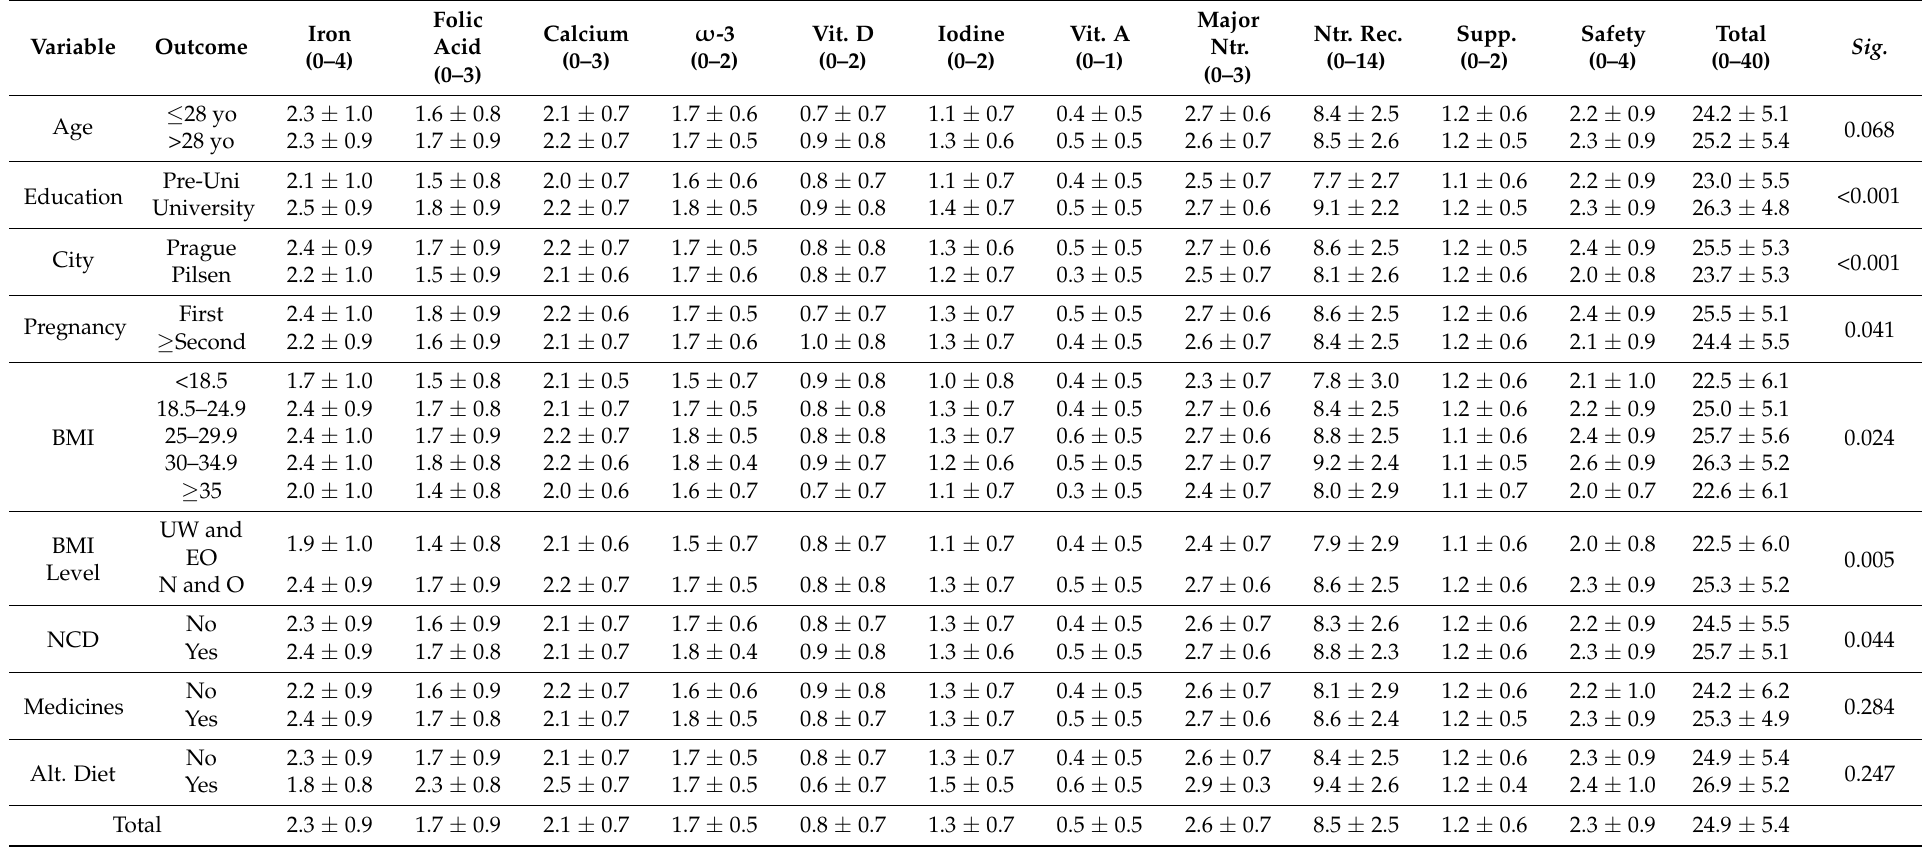
Table 4. Nutritional health knowledge scores of pregnant women participating in the nutritional health survey, April–May 2022 ( n =